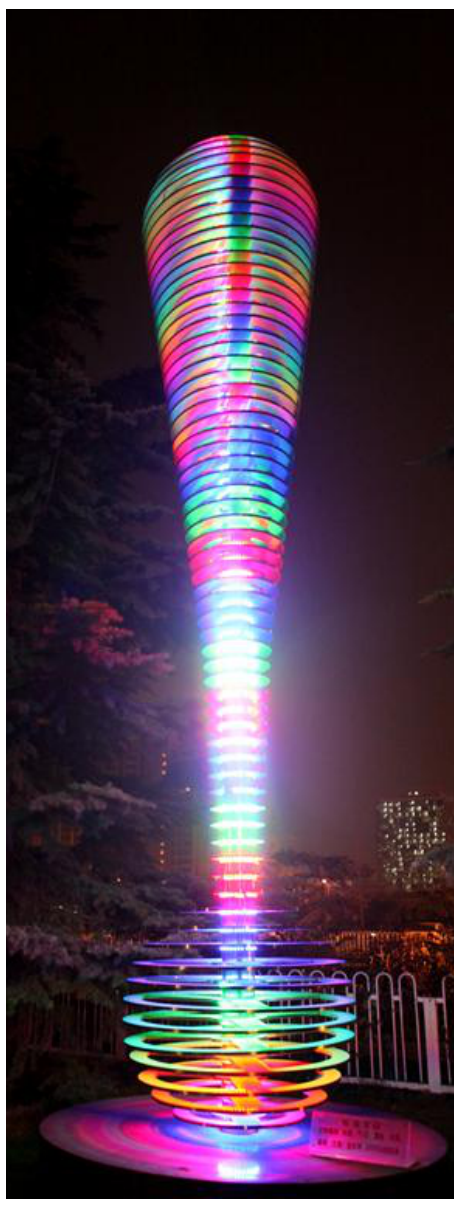
Figure 4. Ralfonso’s EX STRATA SMS and Internet Light Sculpture, Tsinghua University,